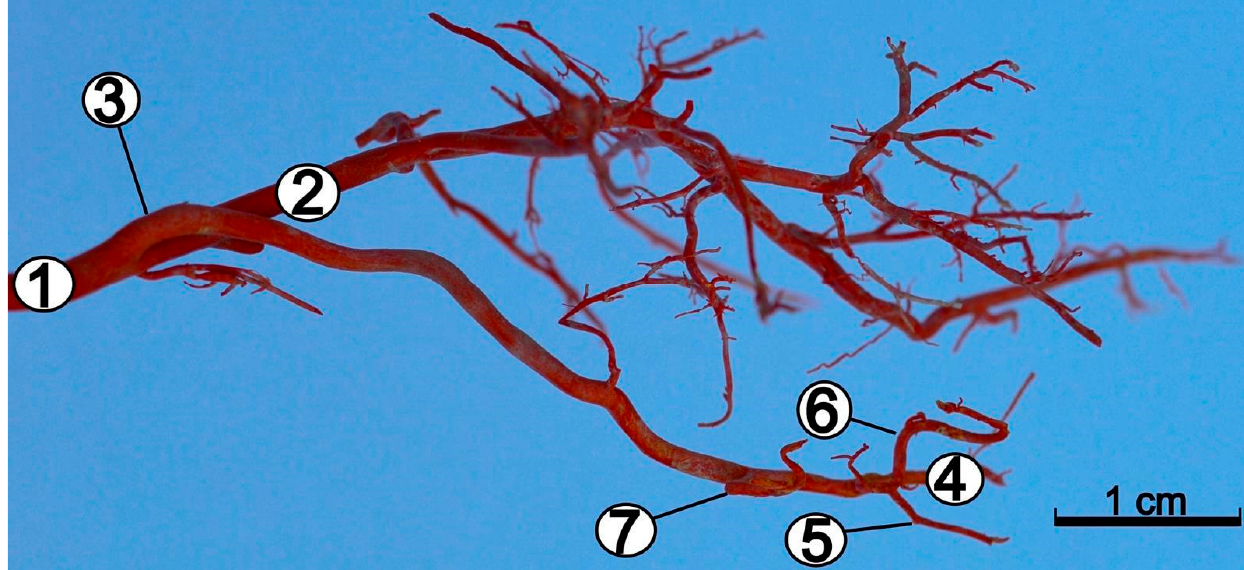
Figure 1. Arteries of the left side of the head of the red-necked wallaby. Corrosion cast. 1—common